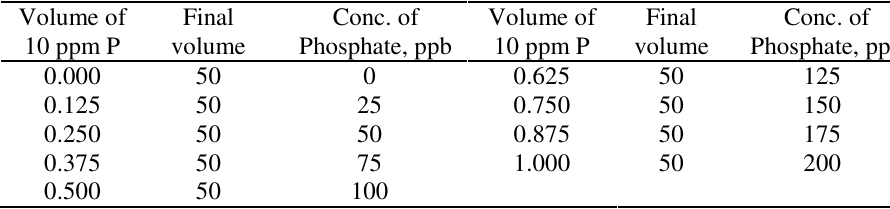
Table 2. Preparation of standard phosphate solution.